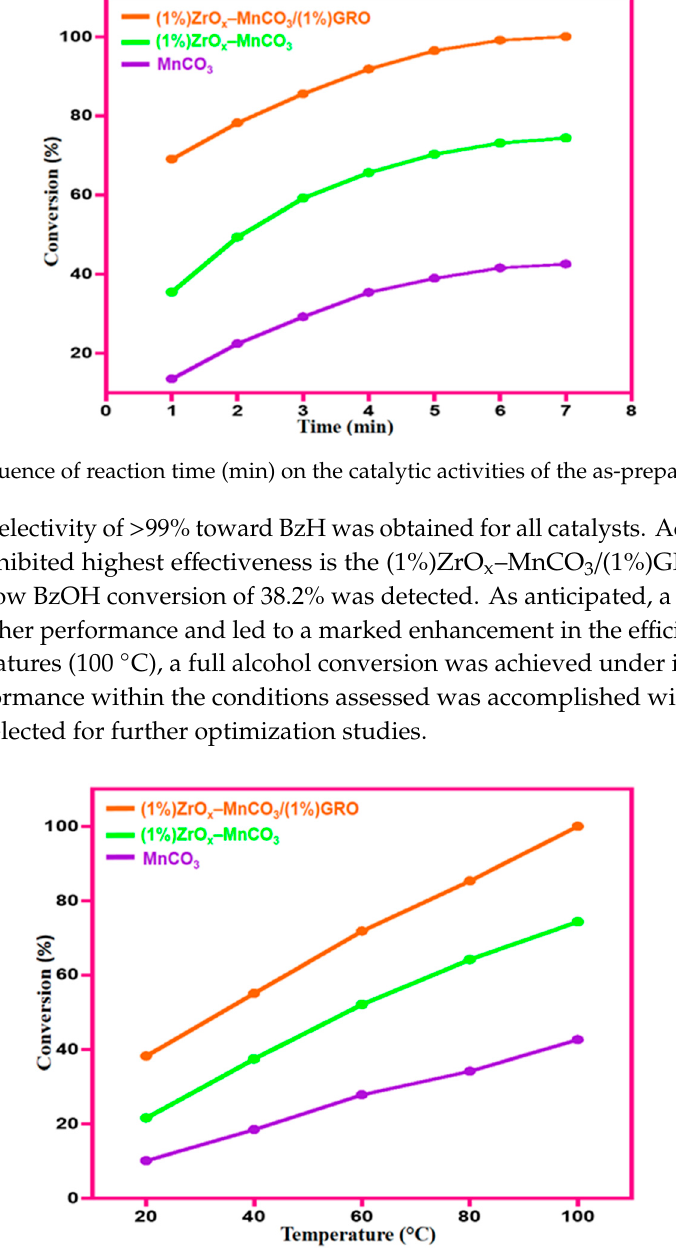
Figure 9. Impact of temperature on the oxidation of BzOH using the as-prepared catalysts.